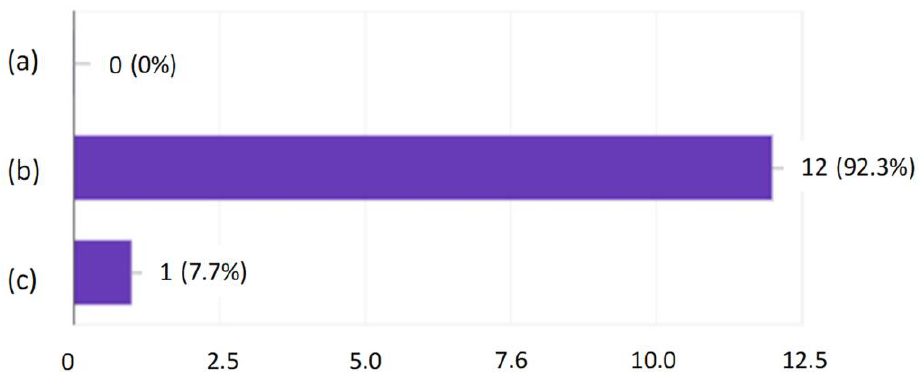
Figure 9. How do you rate the questions asked? ( a ) Difficult; ( b ) Easy; ( c ) Nonstandard; ( d ) They were of varied difficulty, but generally okay.